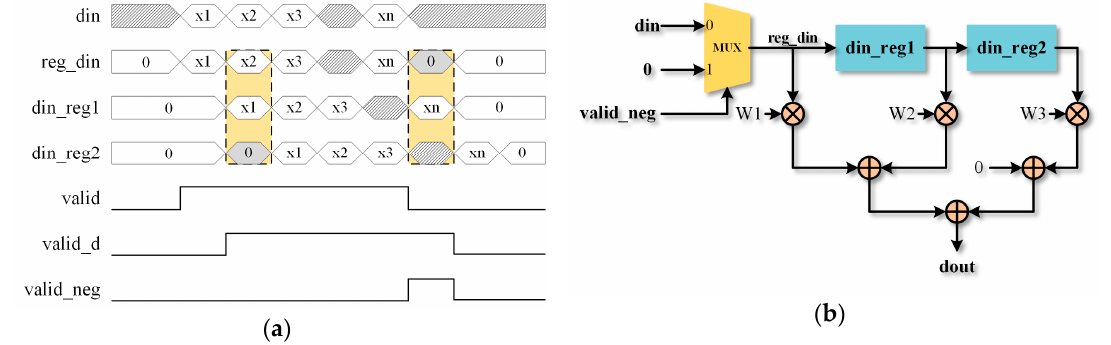
Figure 6. Convolution kernel (CK) design. ( a ) CK’s timing diagram. ( b ) CK’s (Register-Transfer-Level) RTL circuit design.